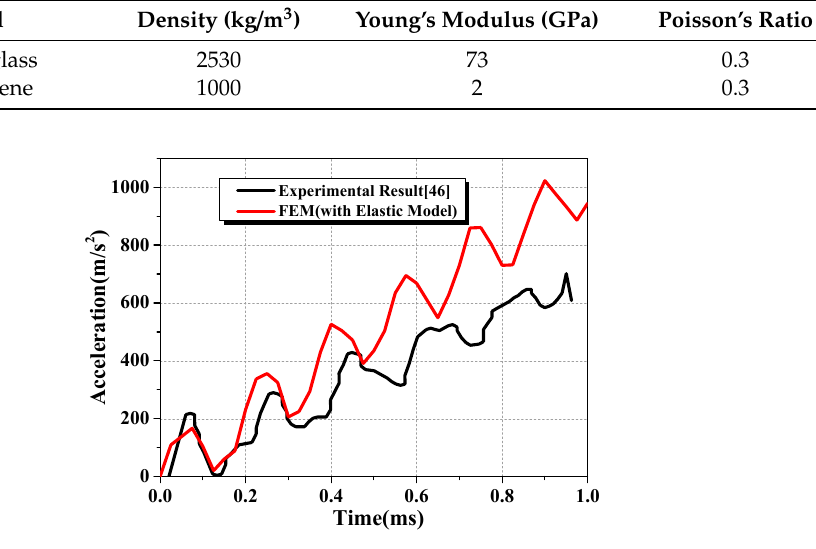
Figure 6. Acceleration-time curves of impactor.